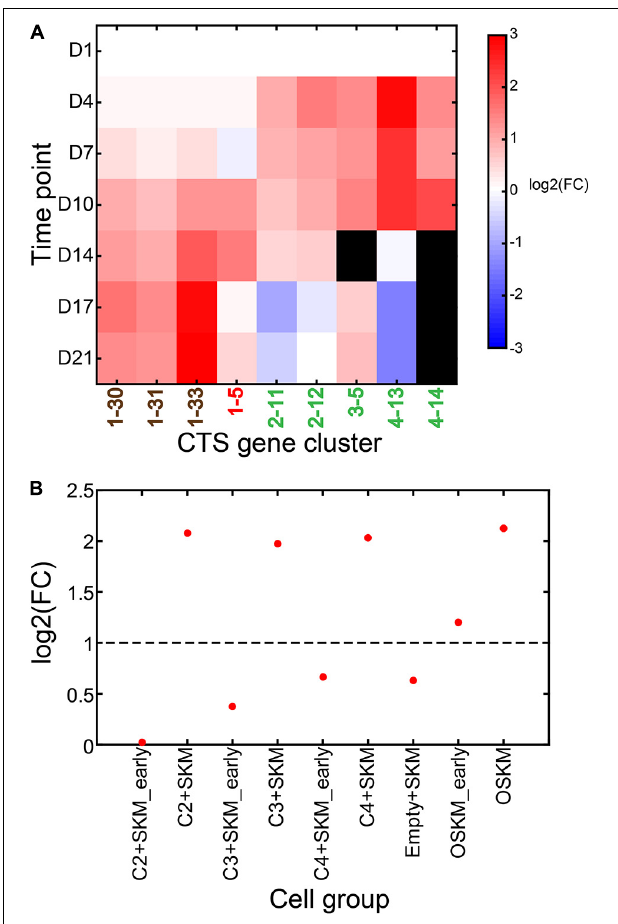
FIGURE 10 | Dynamics of significantly up-regulated CTS gene clusters during the culture of growth factor-induced neural progenitor cells (giNPCs) and induced pluripotent stem (iPS) cells. (A) Expression fold change of the significantly up-regulated gene clusters during the culture of giNPCs compared to mouse embryonic fibroblasts (MEFs). The gene clusters in brown font are associated with brain nonimmune cells; the one in red is associated with stem/progenitor cells; those in green are associated with brain immune cells. (B) Expression fold change of CTS gene cluster 1–5 under different conditions compared to